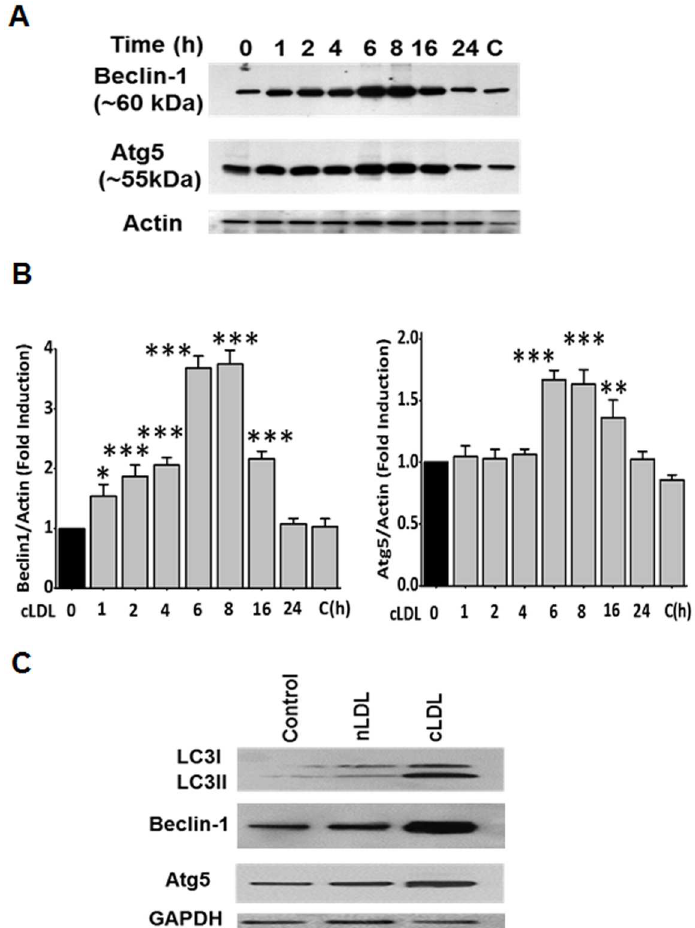
Fig 2. Upregulation of autophagy proteins in response to cLDL treatment. (A left panel) HCAE cells were treated with 100 μ g/ml cLDL for varioustimes as shown. A representative western blot for expressionof autophagy proteins LC3-II, beclin-1, and Atg5 is shown. β -actinwas used as a loadingcontrol. (B) Quantitative analysisfor western blots of Fig 2A are shown in the Fig 2B (left and right panels) for beclin-1and Atg5, respectively. Values are means ± SD, obtained from 3 separateexperiments, Significance of the data was determined by ANOVA, followedby paired-groupcomparisons ( ** p < 0.05), ** p < 0.01, *** p < 0.01 as comparedto untreated controls). (C) cLDL but not nLDL induces autophagy proteins. HCAE cells were treated with 100 μ g/ml cLDL or 100 μ g/ml nLDL for 8 hours and expressionof autophagyproteins was determined by western blots. A representative blot from three separateexperiments for the LC3-II, beclin-1, and Atg5 is shown. As shown there was no inductionof autophagyproteins with nLDL in comparisons to cLDL treated cells. GAPDH was used as a